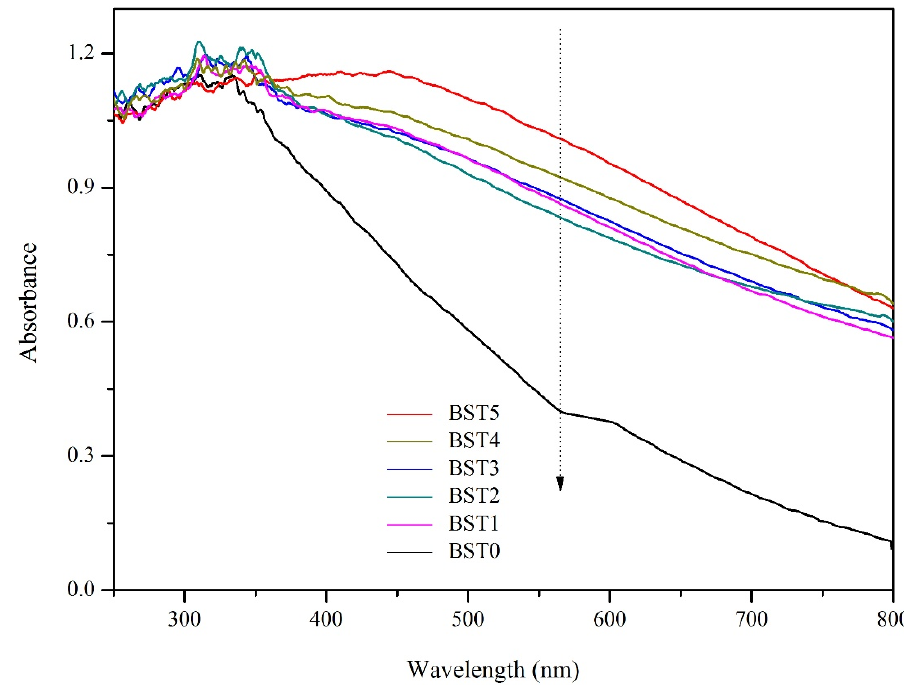
Figure 6. UV-Vis spectrum of Si–Ti composite film prepared at different Bi-doped amounts. The HRTEM photo of the film layer on the surface of wood sample with n (Ti):n (Bi) = 1:0.015 is shown in Figure 8. As can be seen from the figure, clear lattice stripes can be seen in the BST3 sample. The spacing of these lattice stripes was 0.352 nm, corresponding to the 101 crystal plane of AnataseTiO 2 , which was consistent with the results of the XRD test. α -Bi 2 O 3 , these lattice stripes were vague, which may be due to the small amount of Bi 2 O 3 or the low